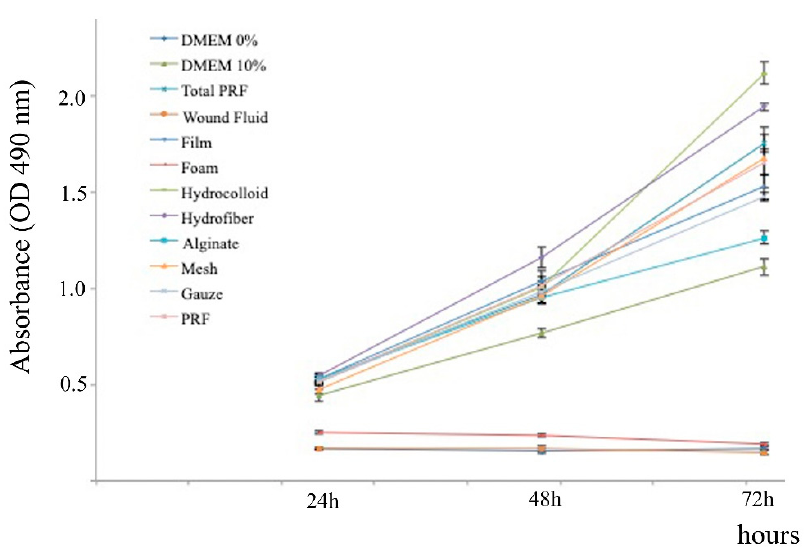
Figure 4. Comparative analysis of the effect of the different combination products’ releasates in the cell proliferation of dermal fibroblasts, measured at 24, 48 and 72 h. The XTT (2,3-bis(2-methoxy-4-nitro-5-sulfophenyl)-5-[(phenylamino) carbonyl]-2H-tetrazolium hydroxide) cell proliferation assay is a colorimetric assay, based on cell metabolic activity, for assessing cell growth and division. In particular, the number of cells present in a condition directly correlates with the absorbance obtained. Of note, the combination product [PRF + Foam] and the simulated wound fluid (WF) exhibit similar behavior, i.e., no proliferation, comparable to the behavior of fibroblast incubated in DMEM without serum.